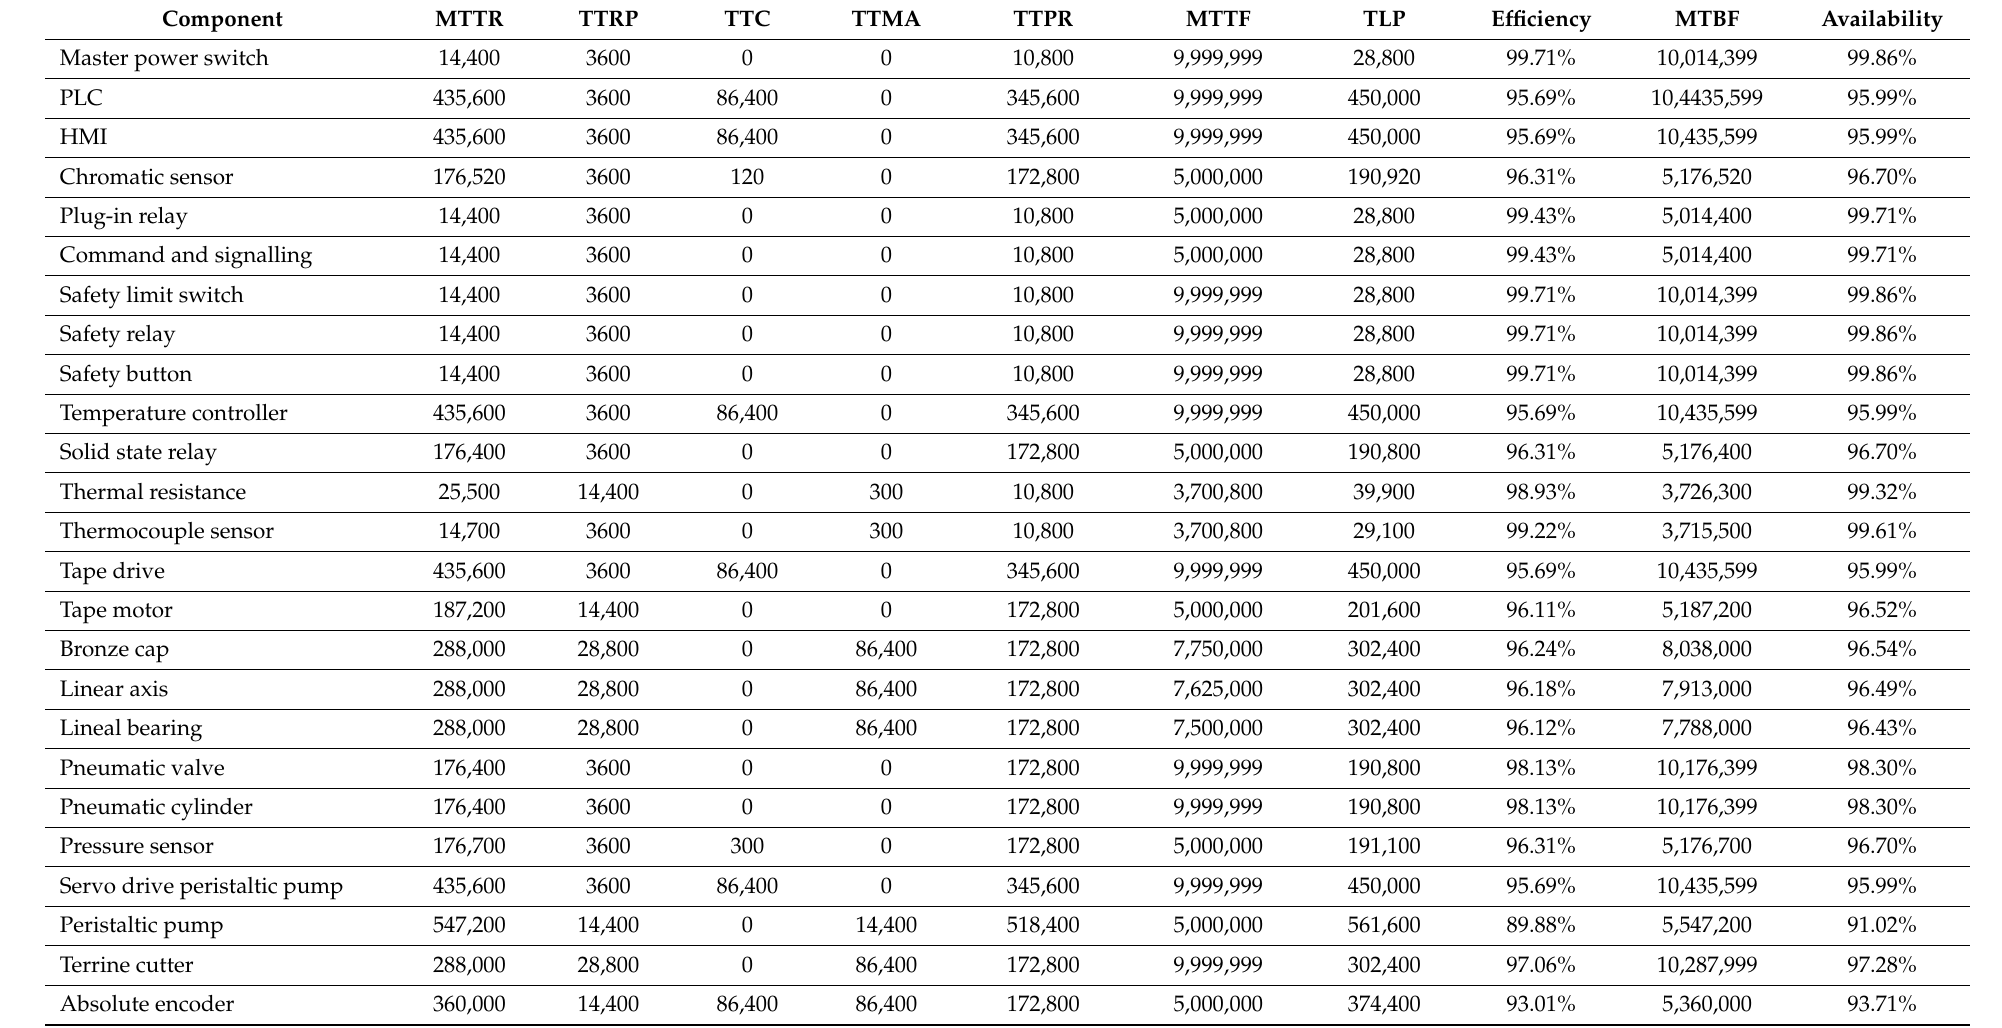
Table 2. Thermoforming components times in seconds. Efficiency and availability in